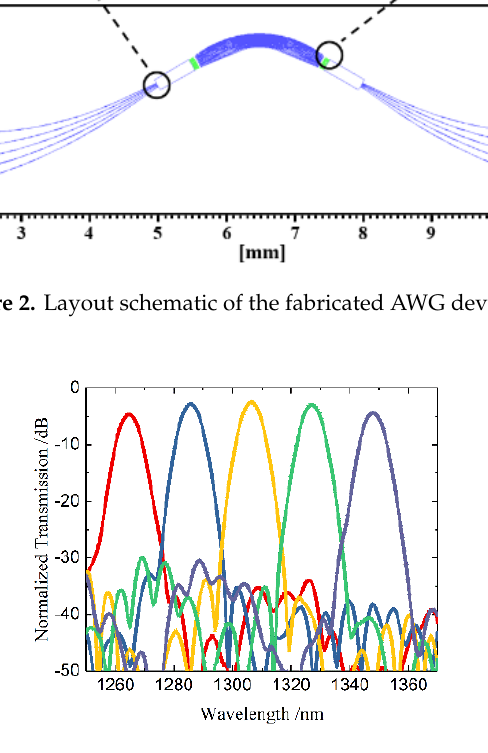
Figure 3. The simulated transmission spectrum of the AWG.